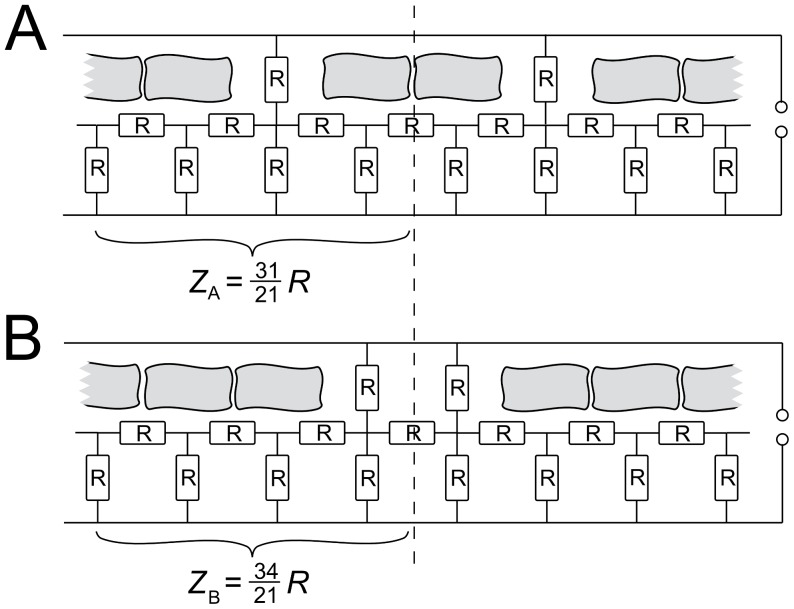
Modeling the impact of clustering on resistance.Illustration of the envisioned impact of distribution of amebas on the electrode. A less-clustered organization (A) with more single amebas produces smaller impedance compared to a more clustered arrangement (B). The impedance depending on the resistant R is calculated for one recurring allotment for each case.